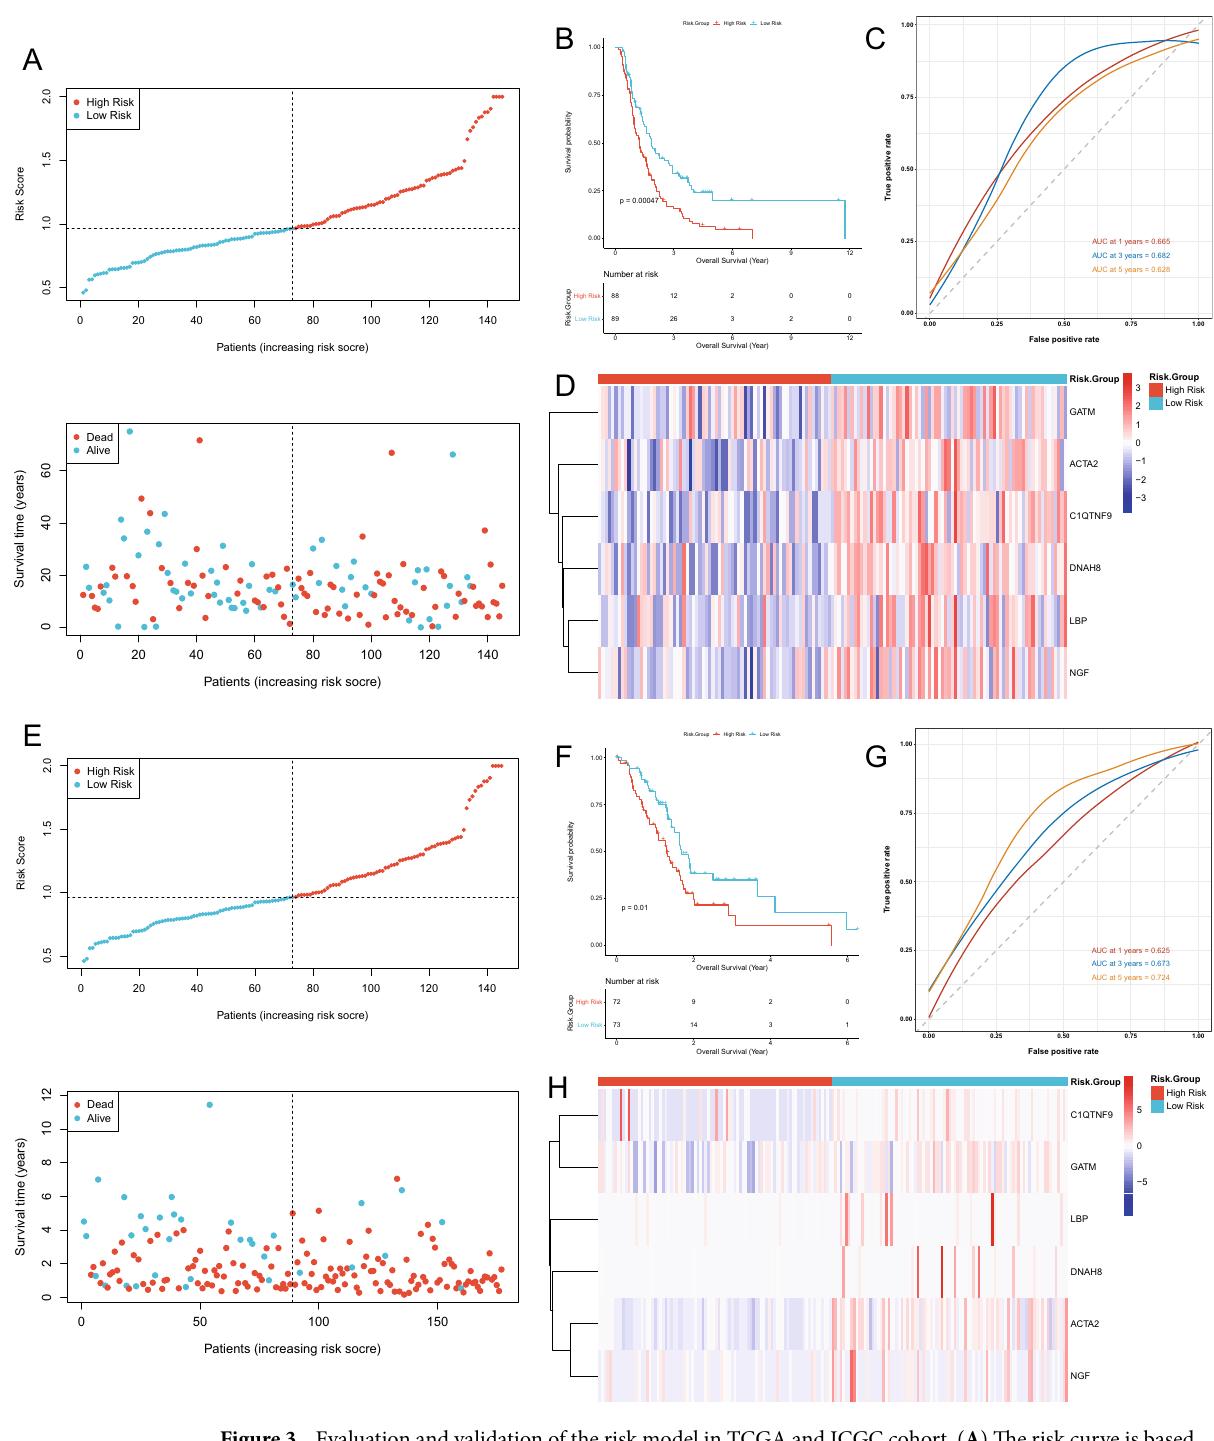
Figure 3. Evaluation and validation of the risk model in TCGA and ICGC cohort. ( A ) The risk curve is based on the risk score of each sample in the TCGA database (top). The scatterplot is based on the survival status of each sample (bottom). The bright and red dots represent low-risk group/survival and high-risk group/death, respectively. ( B ) Kaplan–Meier curves for comparison of the OS between low- and high-risk groups. ( C ) ROC curves demonstrated the predictive efficiency of the risk score. ( D ) Heatmap demonstrating the distribution of the six pyroptosis and inflammasome-related gene expressions in the TCGA cohort. ( E ) The risk curve is based on the risk score of each sample in the ICGC database (top). The scatterplot is based on the survival status of each sample (bottom). The bright and red dots represent low-risk group/survival and high-risk group/ death, respectively. ( F ) Kaplan–Meier curves for comparison of the OS between low- and high-risk groups. ( G ) Time-dependent ROC curves for PDACs. ( H ) The heatmap displayed the expression levels of pyroptosis and inflammasome-related genes in the high-risk and low-risk